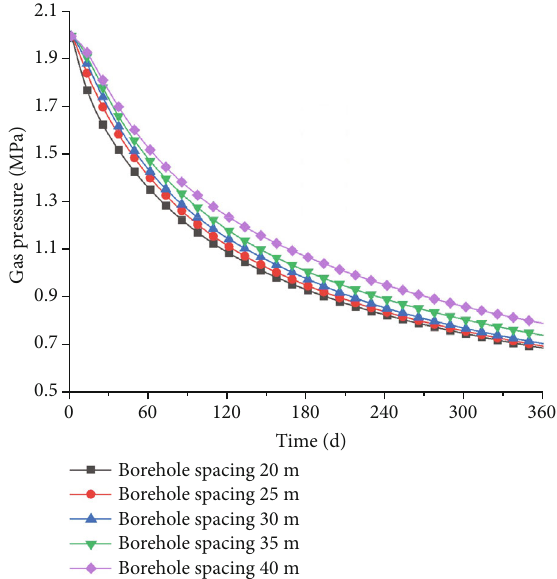
Figure 21: Gas pressure evolutions of monitoring point in nonfully pressure-relief